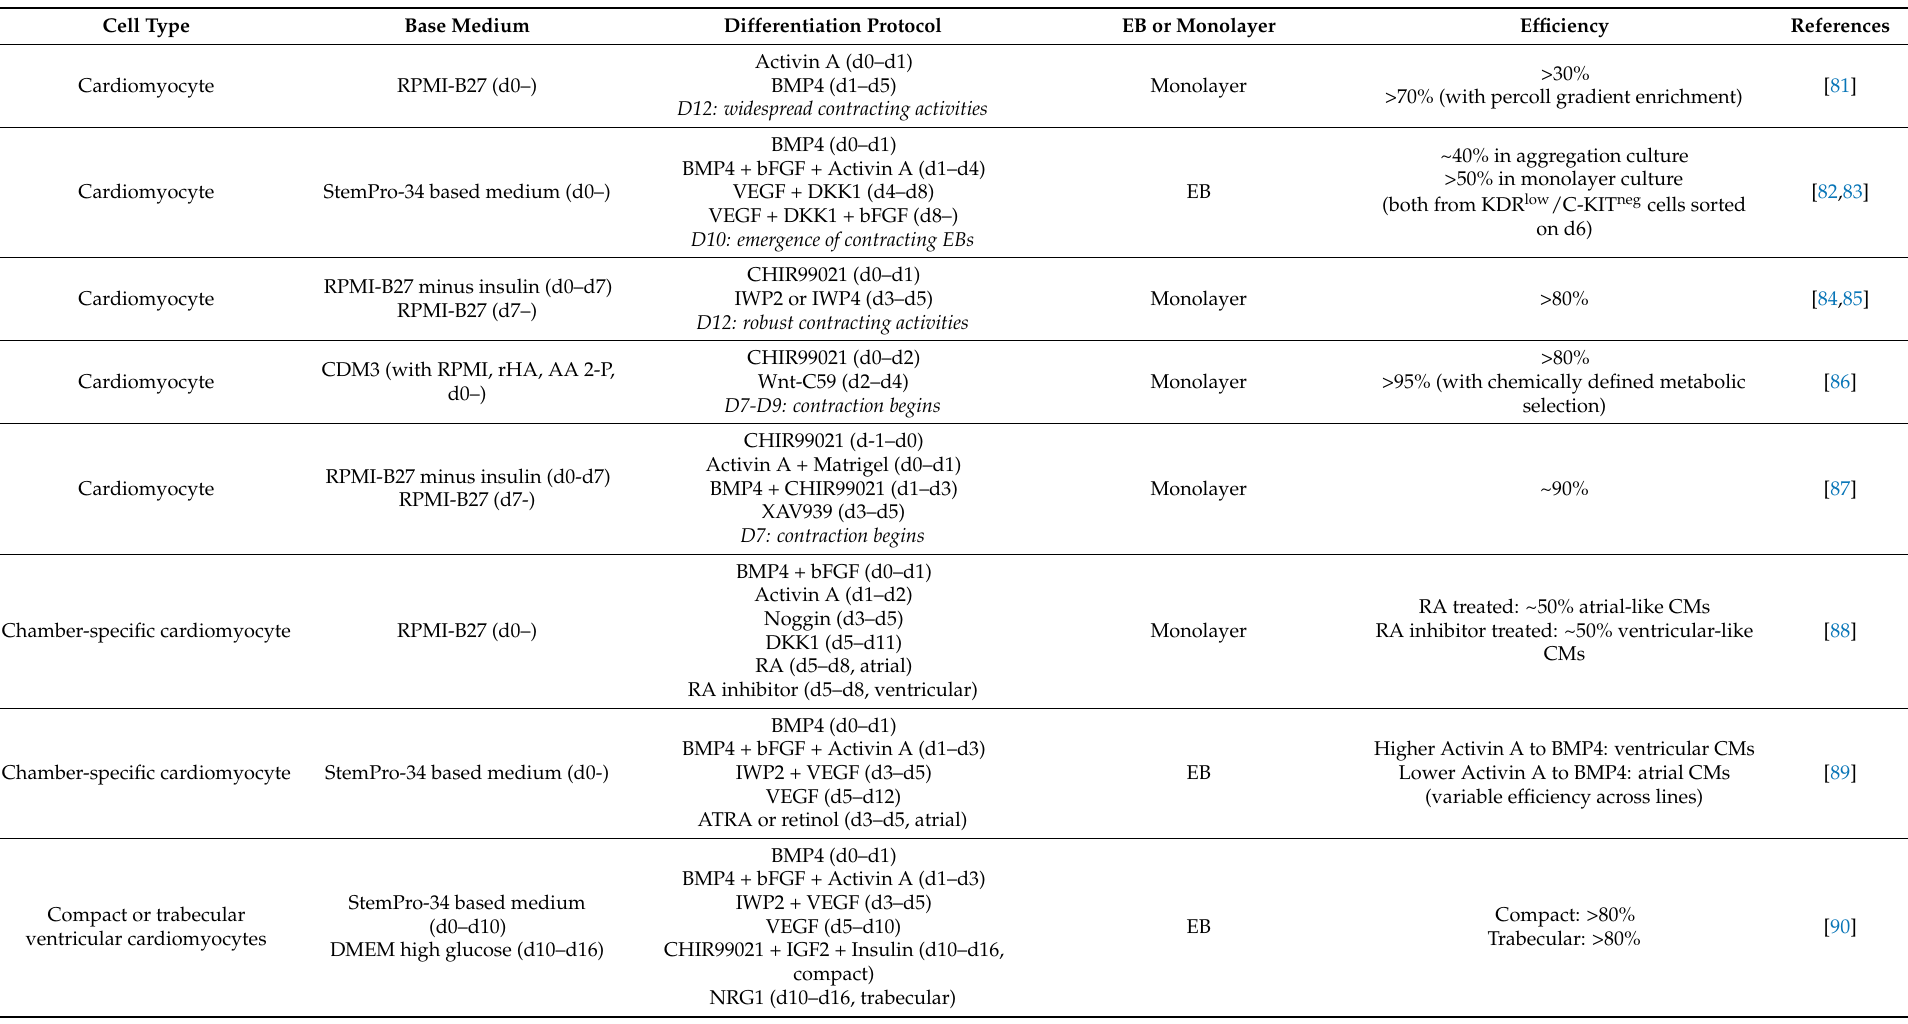
Table 2. Summary of two dimensional (2D) methods for hPSC-based models. D0 marks the start of differentiation. D0-D1 is referred as the first 24 h, D1-D2 as the next 24 h, and so on. See the corresponding reference for more